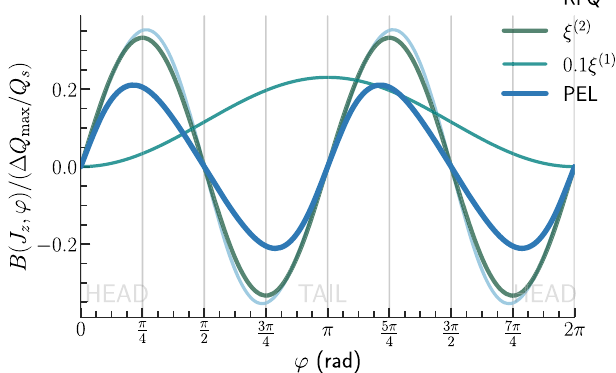
FIG. 1. Comparison between the betatron phase factors B ð J ; φ Þ for a PEL, ξ ð 2 Þ , and an RFQ. The PEL and the RFQ z are matched to the rms bunch length, the value of ξ ð 2 Þ corresponds to the same rms tune spread, J chromaticity ξ ð 1 Þ is shown for